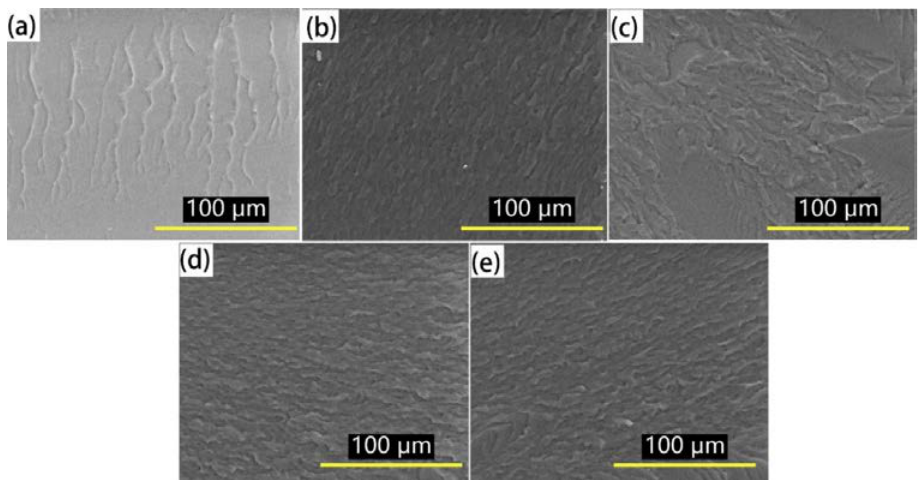
Figure 7. Micrographs of the fracture surface of the unstretched modified epoxy resin with the different w(EHTPB)/w(EP) ratios under liquid nitrogen conditions before tensile testing: ( a )